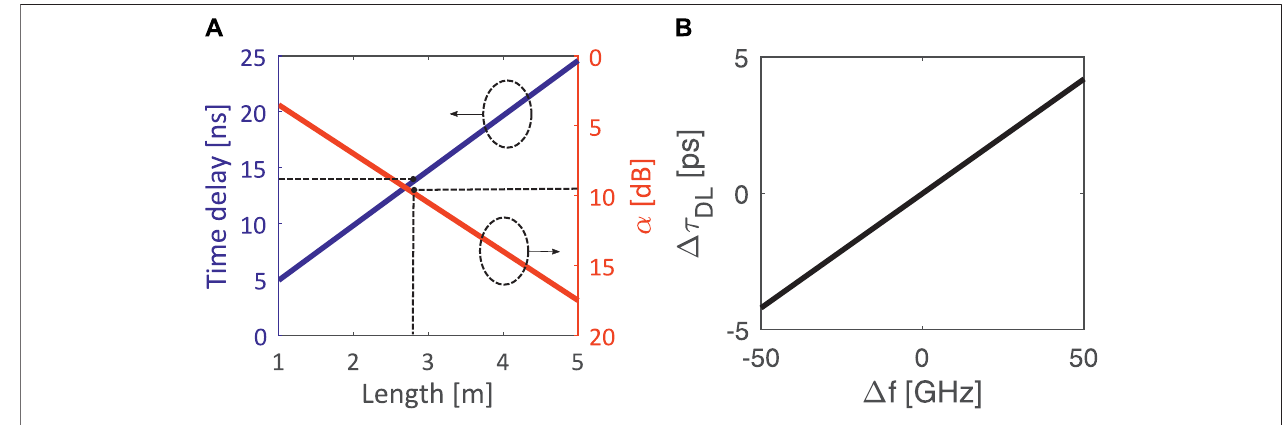
FIGURE 4 | (A) Time delay τ DL and propagation loss α vs. Length at f 0 ; (B) Δτ DL = τ DL (f) — τ DL ( f 0 ) vs. Δ f = f – f 0